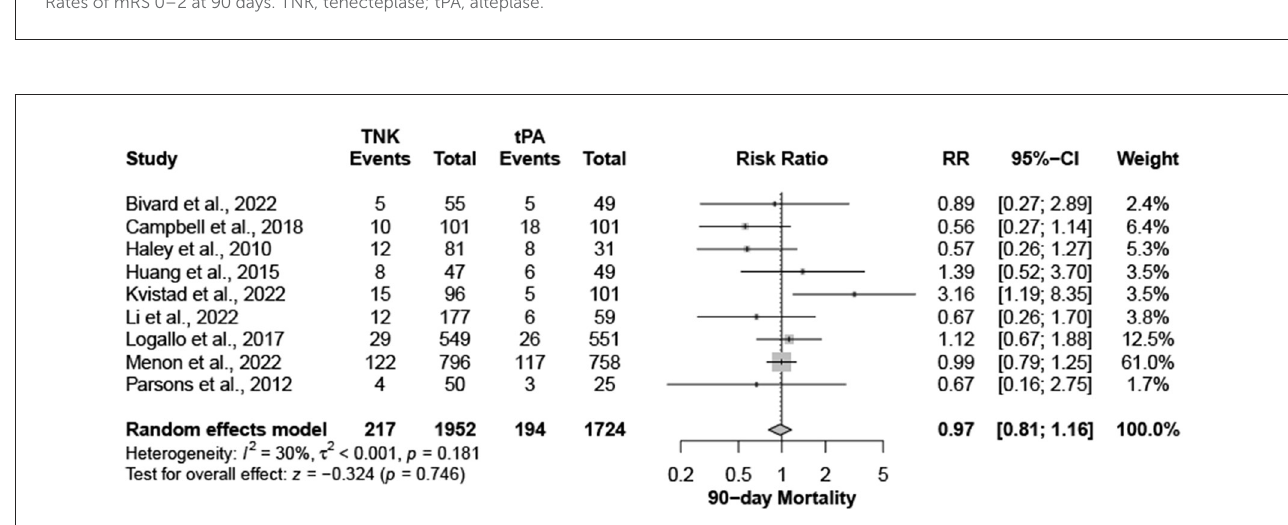
FIGURE3 Rates of mortality at 90 days. TNK, tenecteplase; tPA, alteplase.